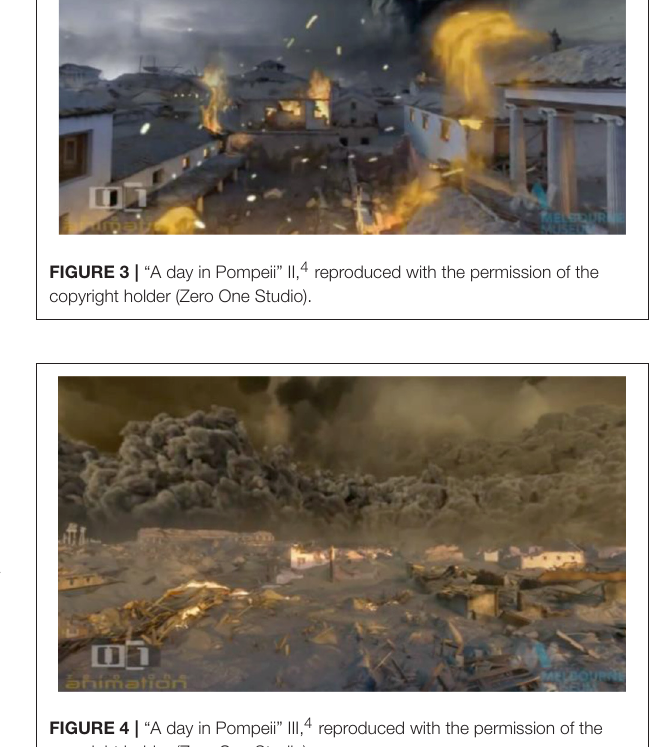
Almost the same narrative canvas will be used in the scenario of the computer game “Time escape: Journey